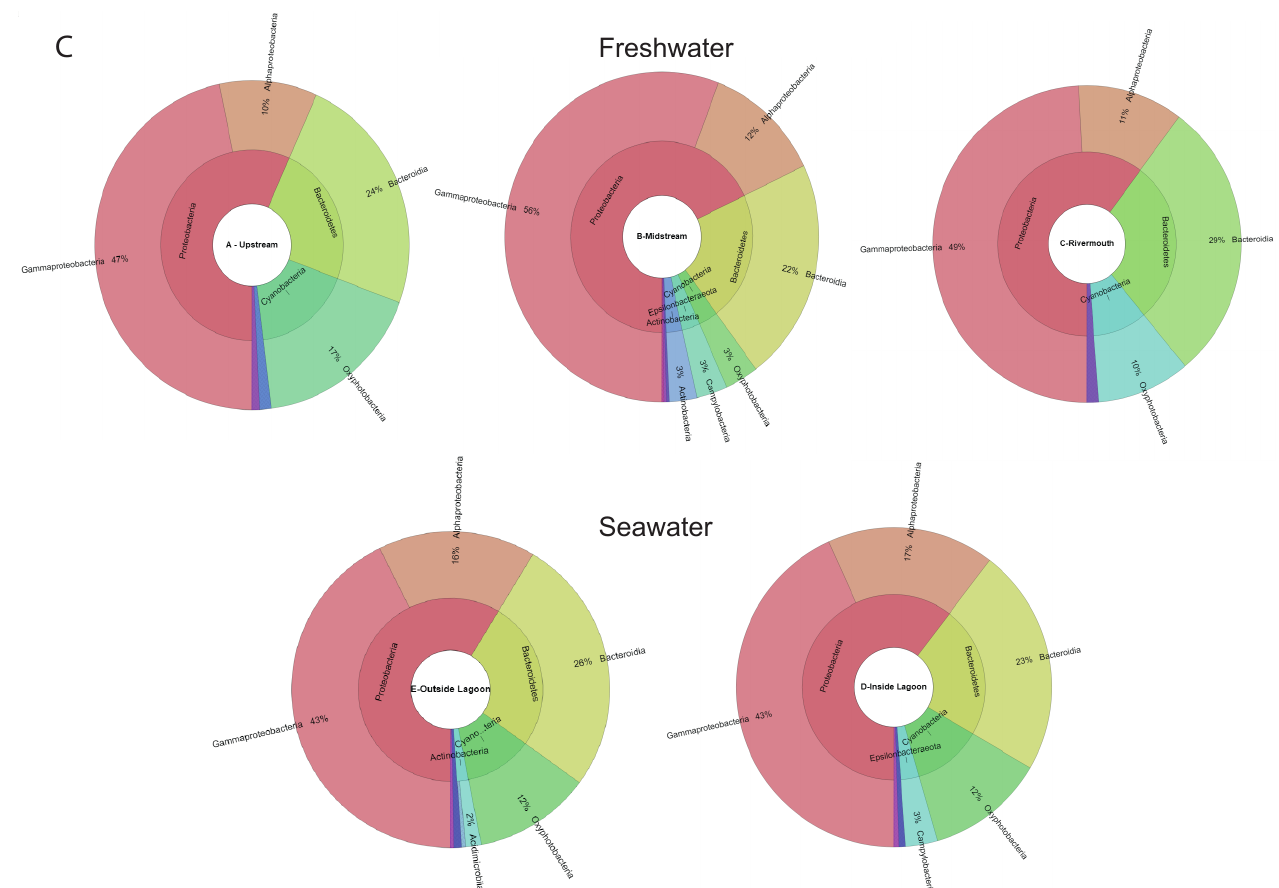
Figure 2. ( A ) Chao1 and Shannon diversity indices of FW and SW for samples collected at the 5 sampling sites, Upstream-A ( n = 15), Midstream-B ( n = 18), Rivermouth-C ( n = 21), Inside-D ( n = 18) and Outside lagoon-E ( n = 16). Differences in FW and SW sample diversity in both metrics are significant (Chao1 p = 0.011, Shannon p = 0.023). ( B ) Bray-Curtis NMDS representation of individual sample communities depicts the separation between sample types (FW, SW). ( C ) Bacterial community composition at phylum and class level for the various sampling sites of the top 100 most abundant ASVs in FW and